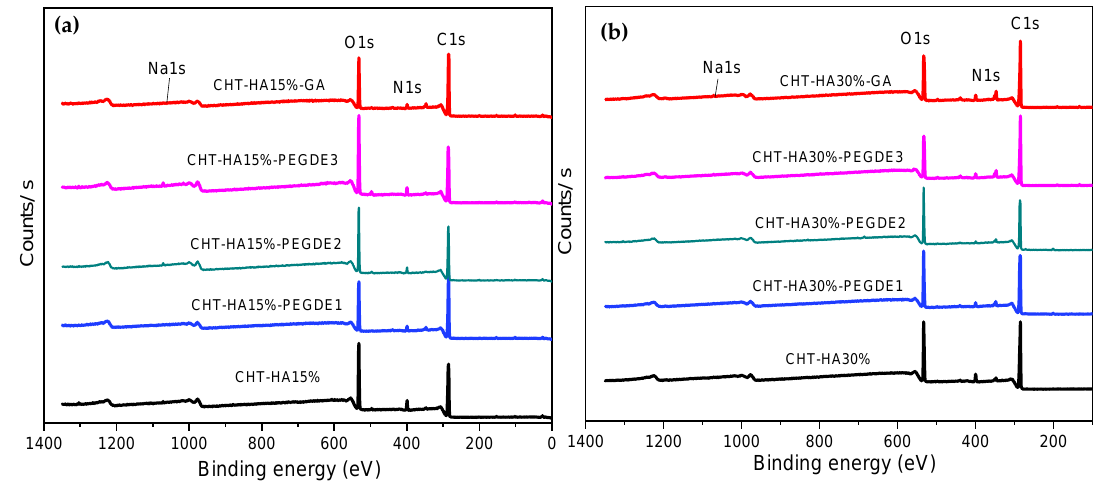
Figure 5. XPS survey spectra of GA crosslinked and PEGDE crosslinked chitosan/HNa films. HNa content of 15% ( a ), HNa content 30% ( b ). Table 4. XPS elemental composition of chitosan/HNa films crosslinked with GA and PEGDE.